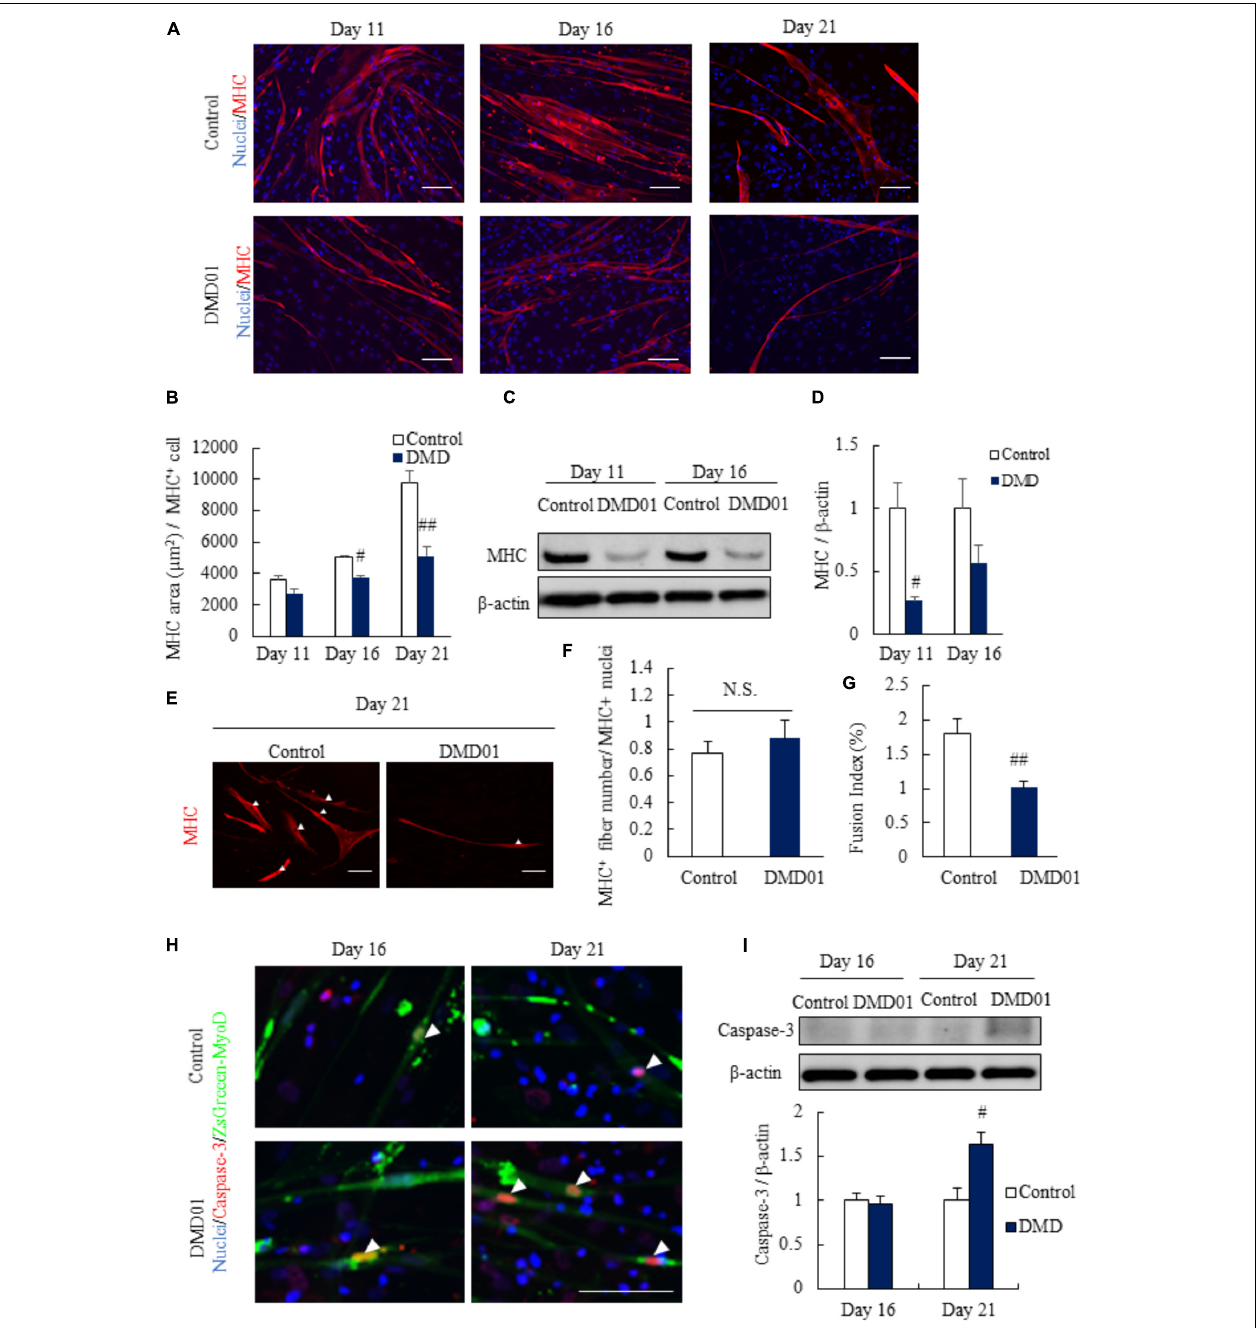
FIGURE 3 | Comparison between myotues from MyoD-transduced fibroblasts of a normal human cell line and a DMD patient. (A) Comparison of myotubes from MyoD-transduced fibroblasts of a control individual and patient with DMD 11, 16, and 21 days after myogenic differentiation using skeletal muscle marker (myosin heavy chain, MHC). (B) Quantification of myotube area in MyoD-transduced fibroblasts of a control individual and a patient with DMD 11, 16, and 21 days after myogenic differentiation by analyzing MHC positive cells. Data are shown as means ± SEM ( n = 3 or 5). ## p < 0.01 and # p < 0.05 vs. Control (Student’s t -test). (C,D) Western blot analysis of MHC in a Ctrl individual and a DMD patient derived myotubes at 11 and 16 days. Data are shown as means ± SEM ( n = 3). # p < 0.05 vs. Control (Student’s t -test). (E,F) Number of nuclei per MHC + myotubes in Ctrl individual and a DMD patient at 21 days. Arrowheads indicate the nuclei. Data are shown as means ± SEM ( n = 5). Scale bar = 100 µ m. (G) Fusion index analysis in Ctrl individual and a DMD patient (DMD01). Data are shown as means ± SEM ( n = 3). ## p < 0.01 vs. Control (Student’s t -test). (H) Comparison of death of myotubes from MyoD-transduced fibroblasts of a control individual and a patient with DMD 16 and 21 days after myogenic differentiation using apoptosis marker (cleaved caspase-3). Arrowheads indicate cleaved caspase-3 positive cells. Scale bar = 100 µ m. (I) Western blot analysis of cleaved caspase-3 in myotubes from MyoD-transduced fibroblasts of a control individual and a DMD patient. Data are shown as means ± SEM ( n = 3). ## p < 0.01 vs. Control and # p < 0.05 vs. Control (Student’s t -test).